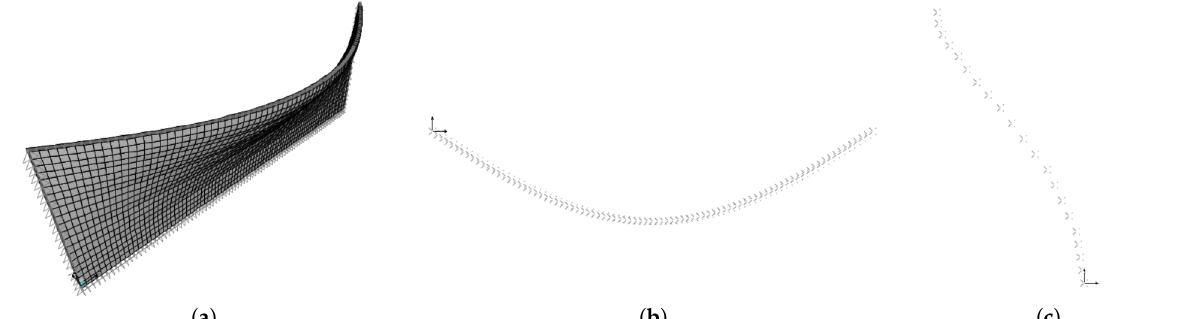
Figure 18. First natural mode of the LW homogenized model. Natural frequency f = 0.46 Hz. Modal shape in the: ( a ) 3D space; ( b ) x − z plane; ( c ) y − z